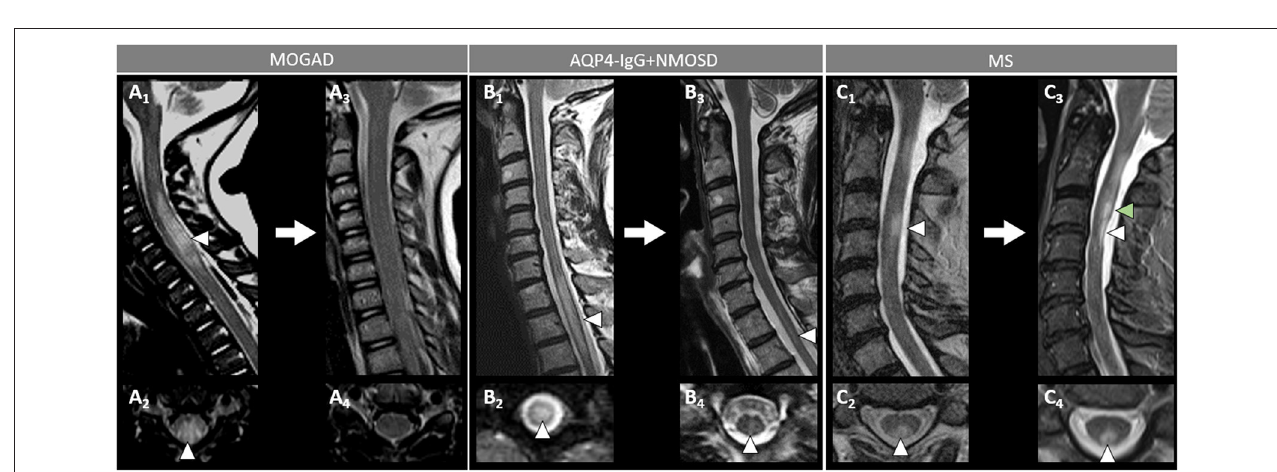
FIGURE 6 | Spinal cord MRI lesion evolution in patients with MOGAD, AQP4-IgG + NMOSD, and MS on T2-images. [ (A) : MOGAD) A longitudinally extensive T2-hyperintense spinal cord lesion with accompanying spinal cord swelling (A 1 , arrowhead) and gray matter involvement (A 2 , arrowhead), with complete resolution at follow-up (A 3 , sagittal, and A 4 , axial view). [ (B) : AQP4-IgG + NMOSD] A longitudinally extensive T2-hyperintense (B 1 , arrowhead), centrally located thoracic spinal cord lesion